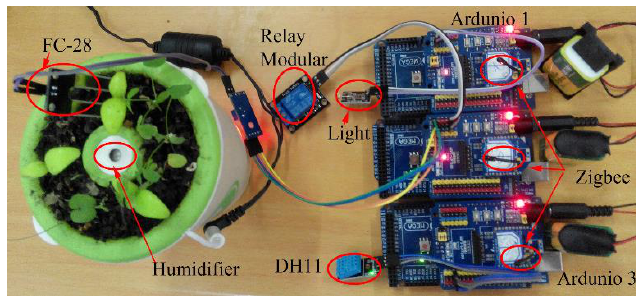
Figure 20. Platform of decentralized decision process of case 2 (to simplify, PC is not included).